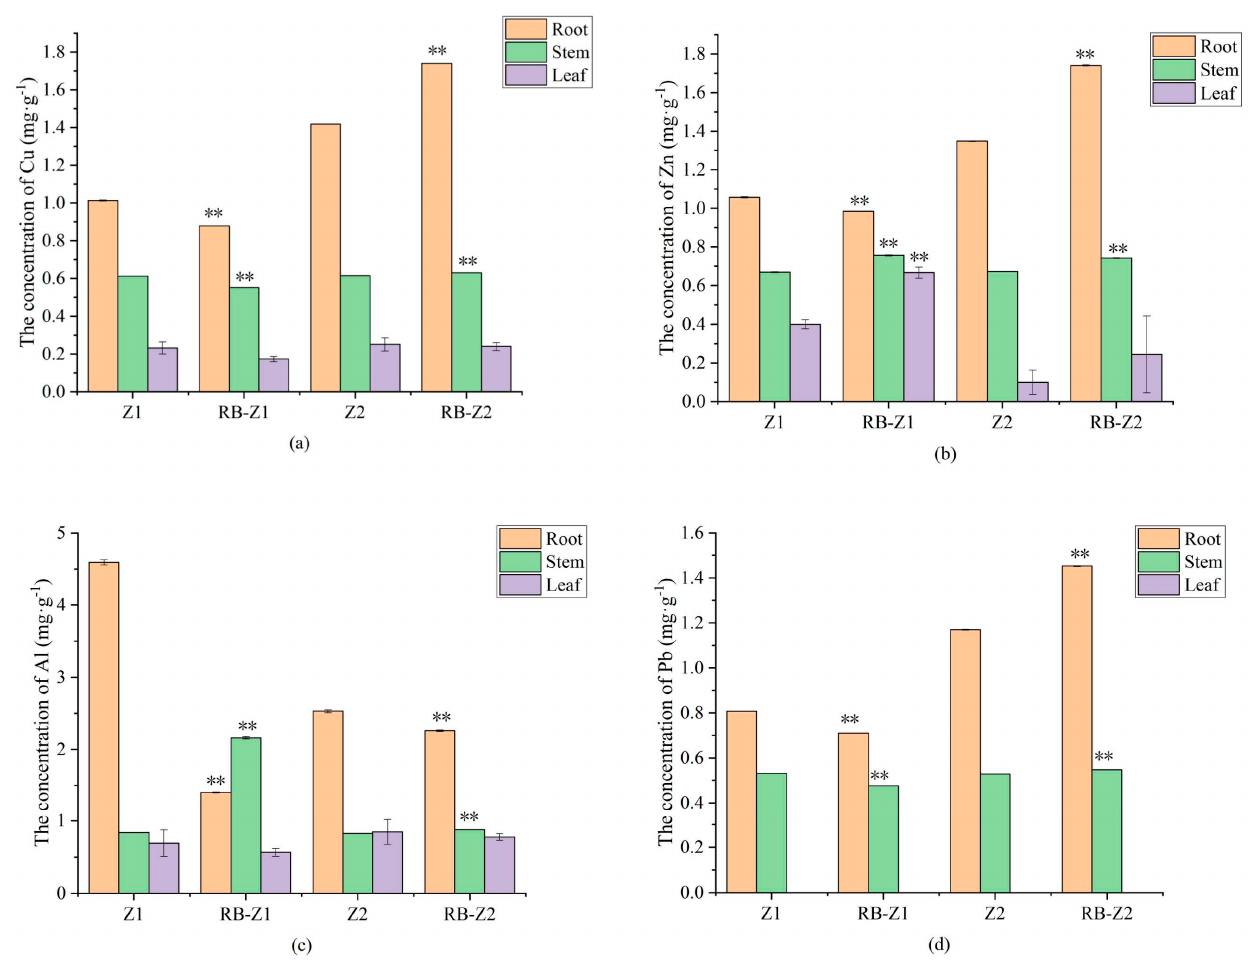
Figure 2. Concentrations of HMs and Al in roots, stems and leaves of plants grown in e ‐ waste dis ‐ mantling soils amended with biochar or not. ( a ) Cu, ( b ) Zn, ( c ) Al and ( d ) Pb. The data are means ± SD, n = 3. Asterisks (**) denote a value significantly greater than the corresponding control value ( p ≤ 0.01).